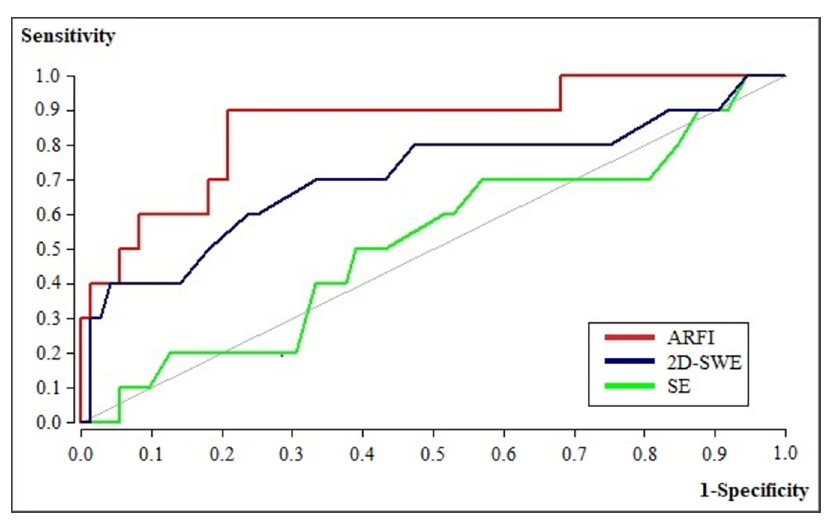
Fig 5. Comparison of ROC-Curves for SE, ARFI and